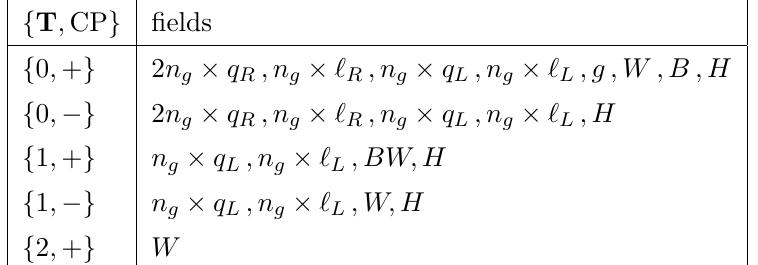
as z ! 1. Such a cuto(cid:11) is mandatory for I = 2 because there are PDF contributions that are SU(2) non-singlets. The evolution equations for SU(3) are regular in the absence of a cuto(cid:11), as hadron PDFs are color singlets. Similarly for U(1), the unpolarized PDFs